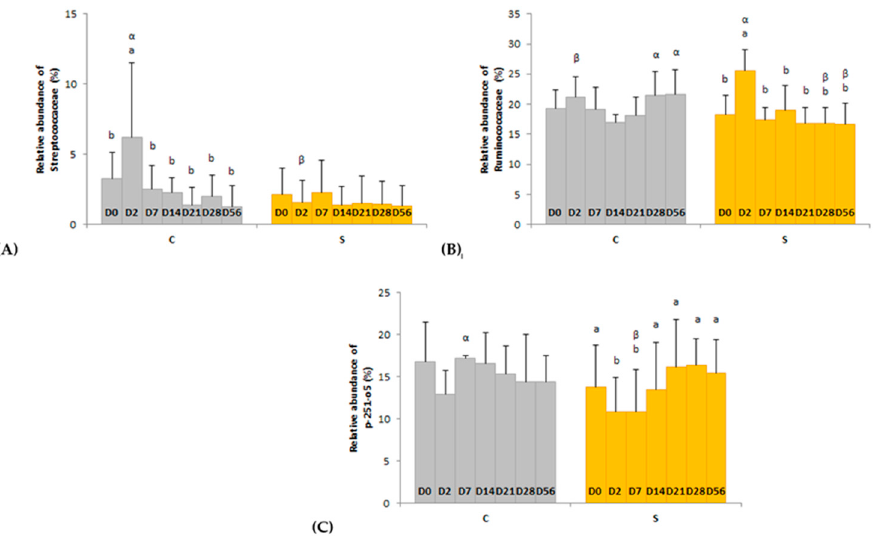
Figure 5. Day × supplementation interactions for three families: ( A ) Streptococcaceae, ( B ) Ruminococcaceae and ( C ) p-251-o5. For each plot, different Latin superscripts (a, b) indicate significant variations between days for each supplementation. Different Greek superscripts ( α , β ) described significant variations between supplementations for each day. The two modalities of supplementation are control (C) and supplemented (S) groups. Error bars are based on standard deviations for each day (D).